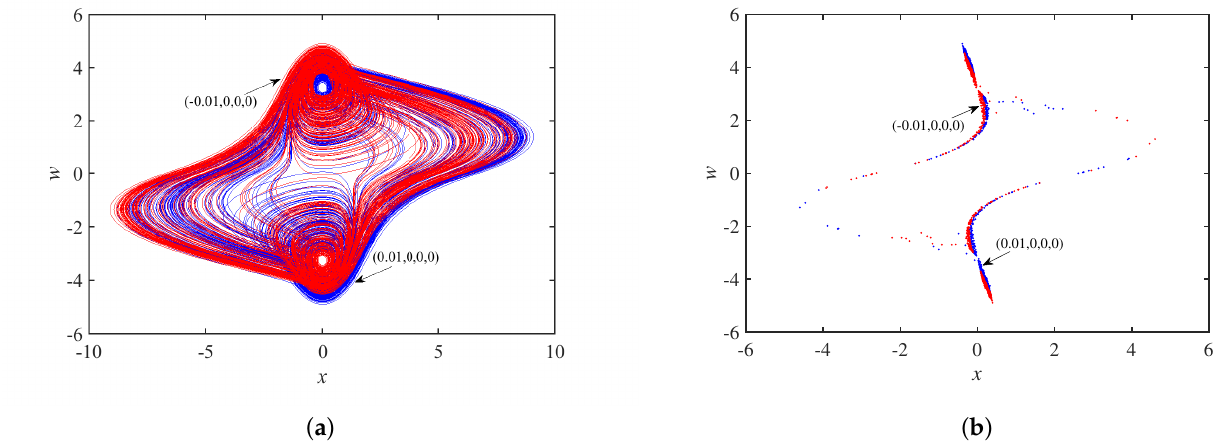
Figure 15. When a = 40, b = 0.15, c = − 0.25: ( a ) coexisting double-scroll attractors; ( b ) Poincaré maps.